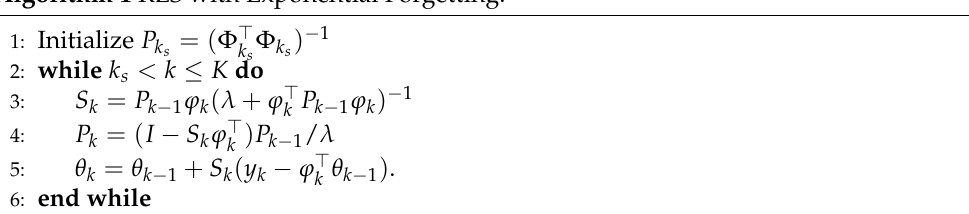
Algorithm 1 RLS with Exponential